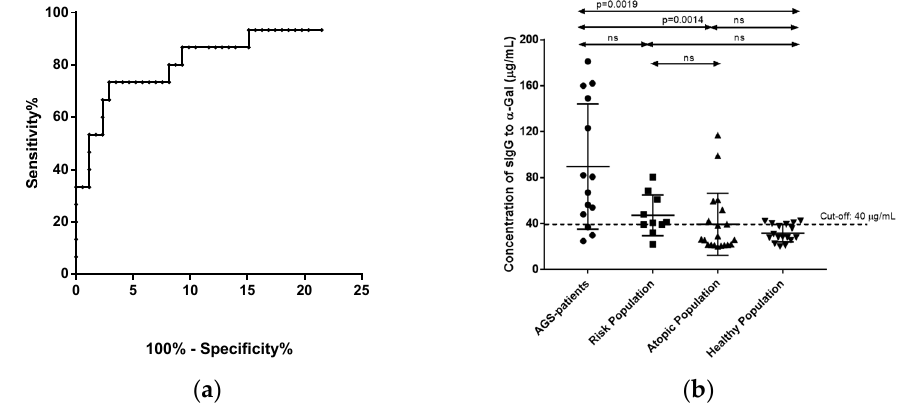
Figure 2. ROC curve ( a ) and distribution of the studied populations considering 40 µg/mL as sIgG to α -Gal cut-off value ( b ). AGS patients (circles) ; Risk Population (squares); Atopic Population (triangles upward); Healthy Population